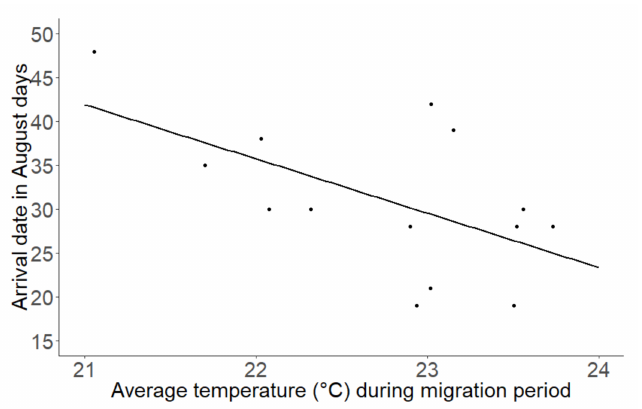
Figure 1. The arrival date (in August days) at the study site versus the average temperature at the stopover site during the autumn migration period during the period of